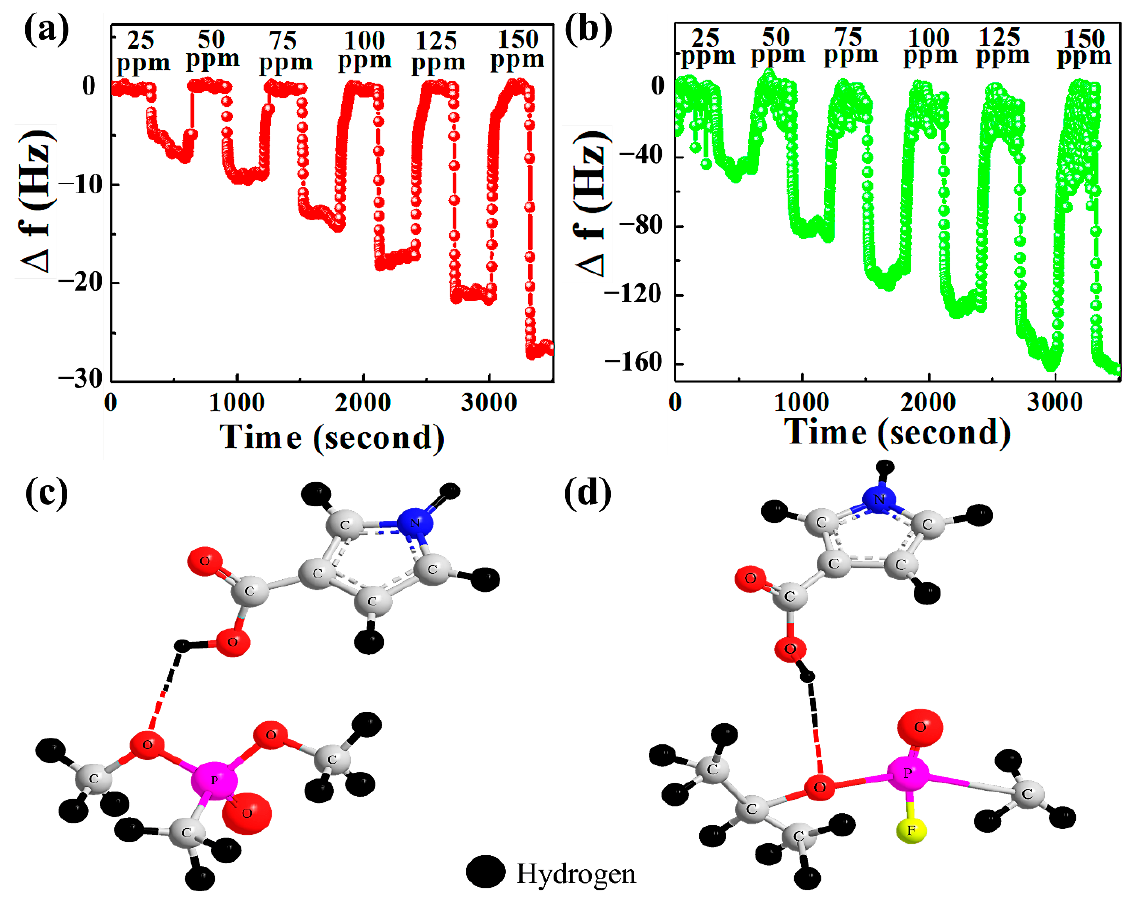
Figure 5. Frequency shifts of ( a ) NGO@MnO 2 , ( b ) NGO@MnO 2 /PPy in the QCM sensor ( T = 20 °C, R.H. = 25–30%) and 3D computed graphics of hydrogen bond formation between ( c ) PPy and DMMP, and ( d ) PPy and Sarin. Figure ( c , d ) are not to scale.